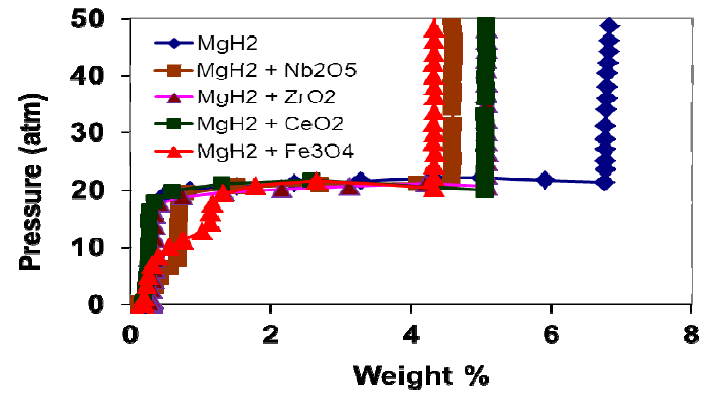
and catalyzed MgH 2